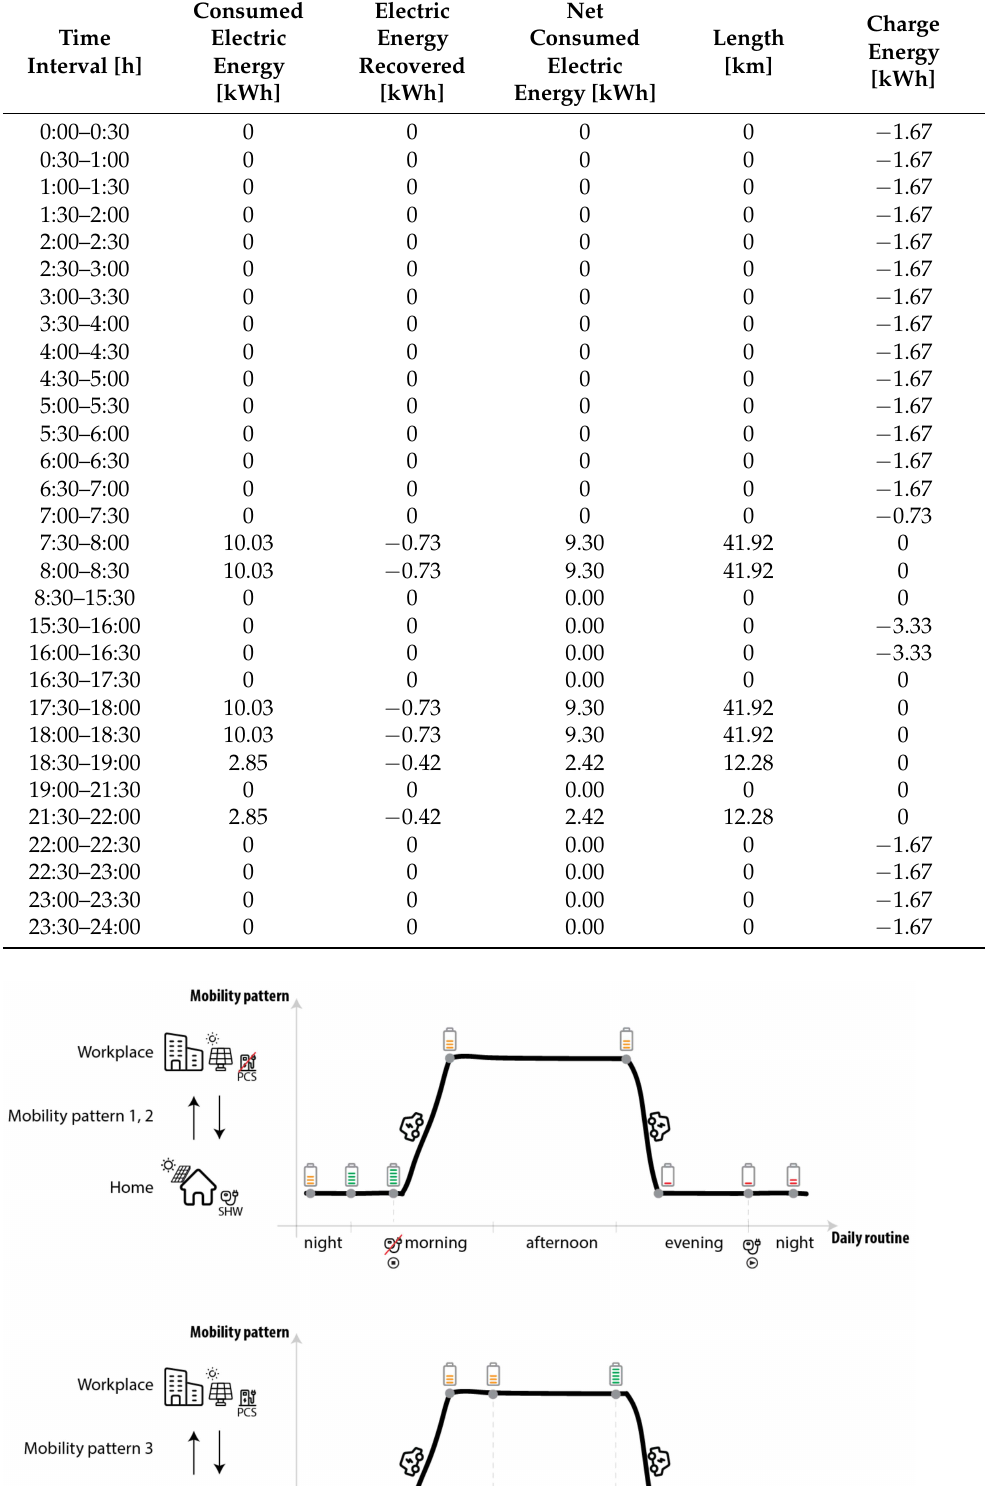
Table 13. Mobility pattern 3 results.